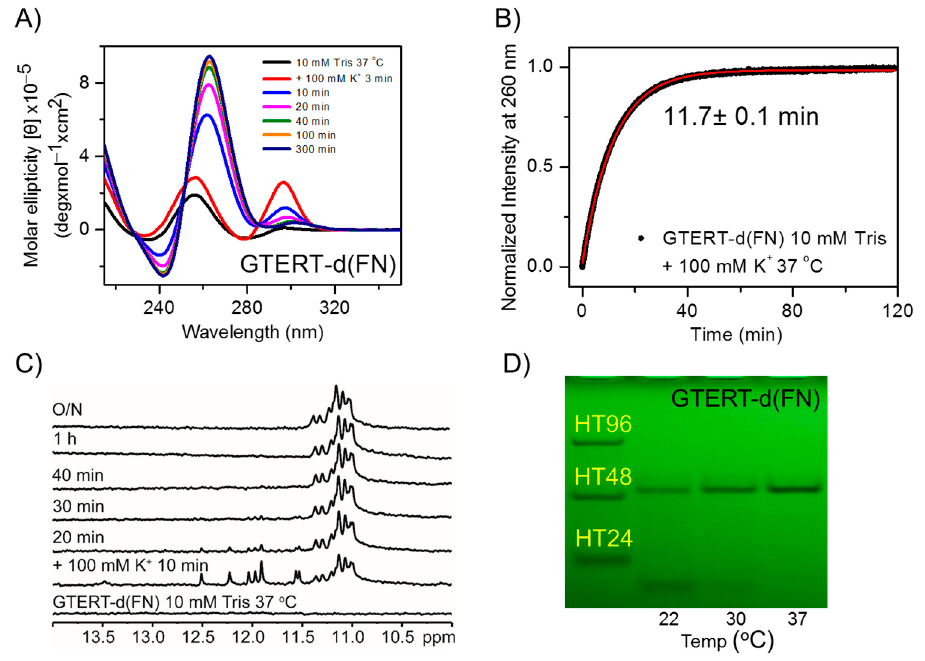
Figure 1. Structural conversion of GTERT-d(FN) in a K + solution. ( A ) Time-dependent CD spectra of GTERT-d(FN) in a 100 mM K + solution at 37 °C. ( B ) The arising time of G4-2 signals is 11.7 ± 0.1 min, obtained from a single exponential fitting at 265 nm. ( C ) Time-resolved imino proton spectra of GTERT-d(FN) recorded at 0, 10, 20, 30, 40, and 60 min together with overnight after the addition of 100 mM K + . ( D ) UV shadowing of gel assay of GTERT-d(FN) in a 10 mM Tris buffer after the 1 h addition of a 100 mM K + at 22 °C (lane 1), 30 °C (lane 2), and 37 °C (lane 3) at a DNA concentration of 80 μ M.